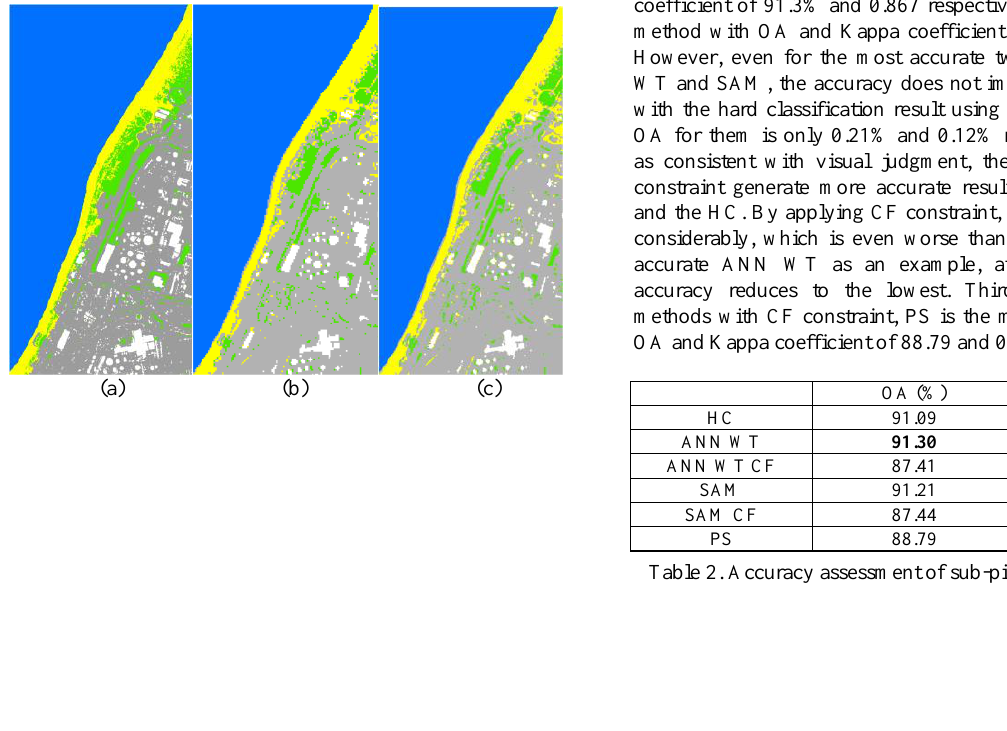
Figure 5. Sub-pixel mapping results where blue, yellow, white and grey pixels represent water body, sandy beach, high- reflection objects and low-reflection objects. (a) Reference map. (b) HC. (c) ANN WT. (d) ANN WT CF. (e) SAM. (f) SAM CF. (g) PS.